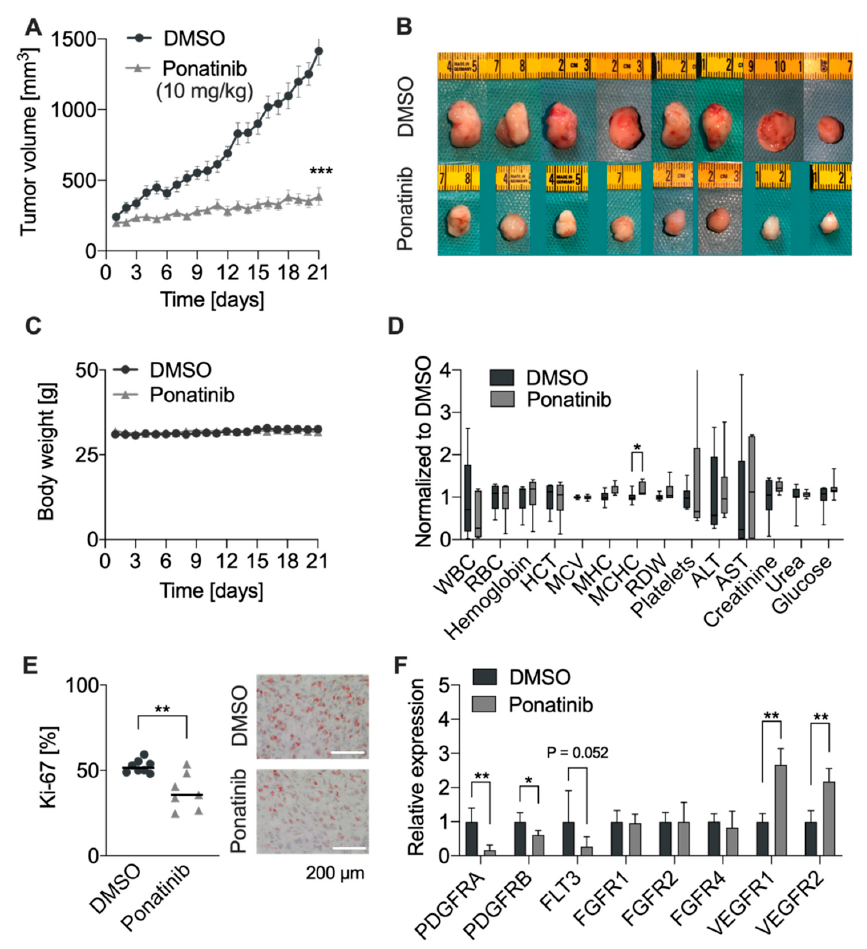
Figure 4. Ponatinib inhibited tumor growth in vivo: ( A ) NCH93 tumor-bearing were randomized into two groups after reaching a tumor size of 200 mm 3 . Mice were treated with ponatinib (10 mg/kg body weight, i.p. daily) for 21 days. Ponatinib significantly inhibited NCH93 tumor growth in NMRI/nu mice. ( B ) On day 21, mice were sacrificed and tumors were excised. ( C ) Mice weight was not affected by the treatment. ( D ) Blood samples from the mice were drawn immediately after killing and were then analyzed. Hematological parameters remained unchanged except for a minor change in MCHC. ( E ) Ki-67 expression indicated a significant decrease in the proliferation of ponatinib-treated tumors (left). Representative images of Ki-67 stained tumor sections (right). Bar represents 200 µ m. ( F ) mRNA levels of PDGFRA and PDGFRB were reduced and mRNA levels of VEGFR1 and VEGFR2 were increased upon ponatinib treatment. * p < 0.05; ** p < 0.01; *** p <